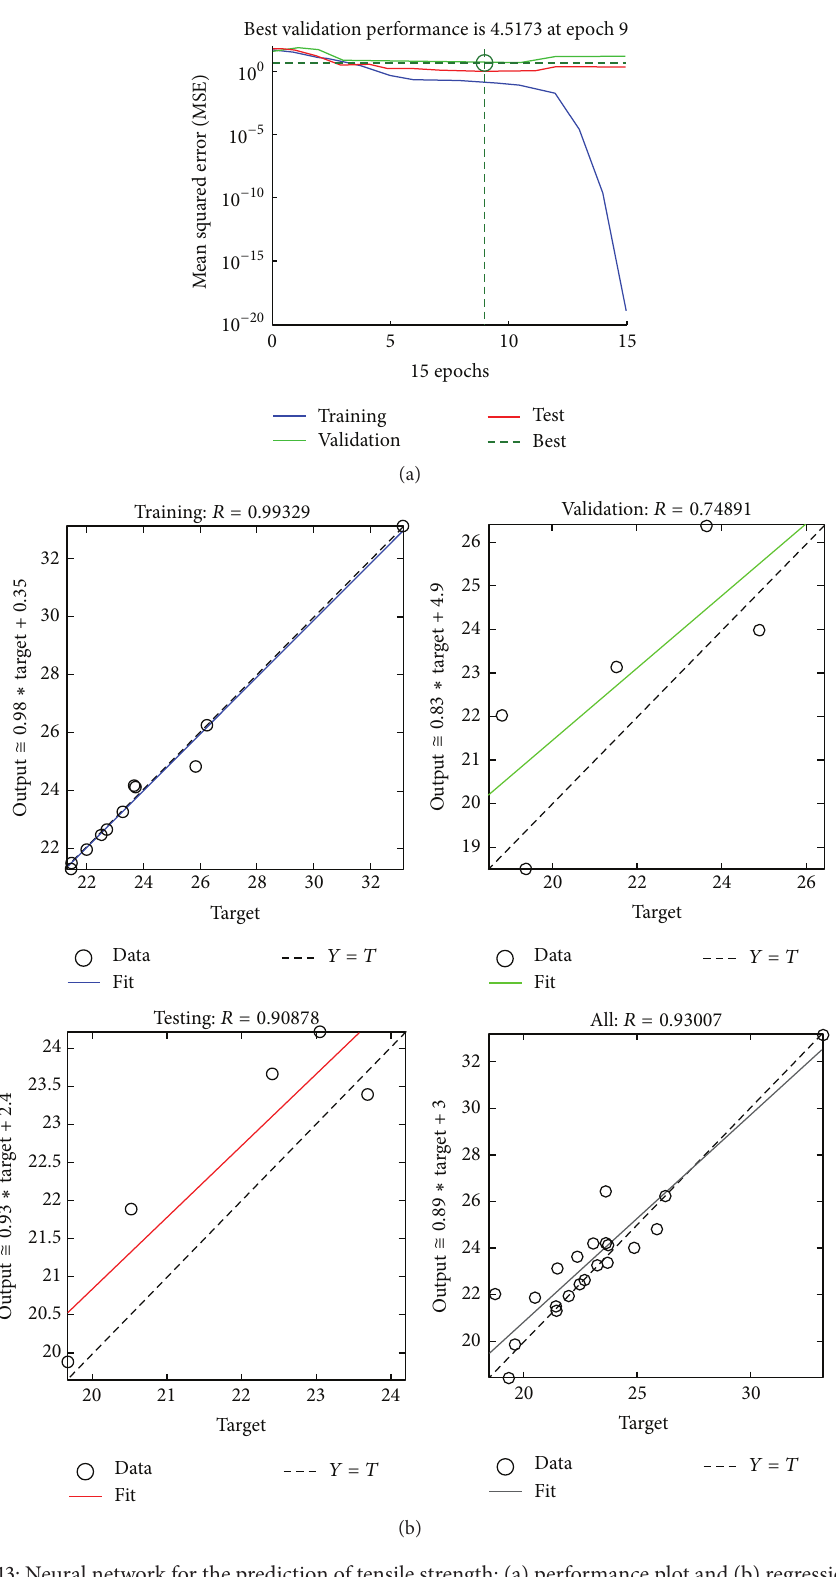
Figure 13: Neural network for the prediction of tensile strength: (a) performance plot and (b) regression